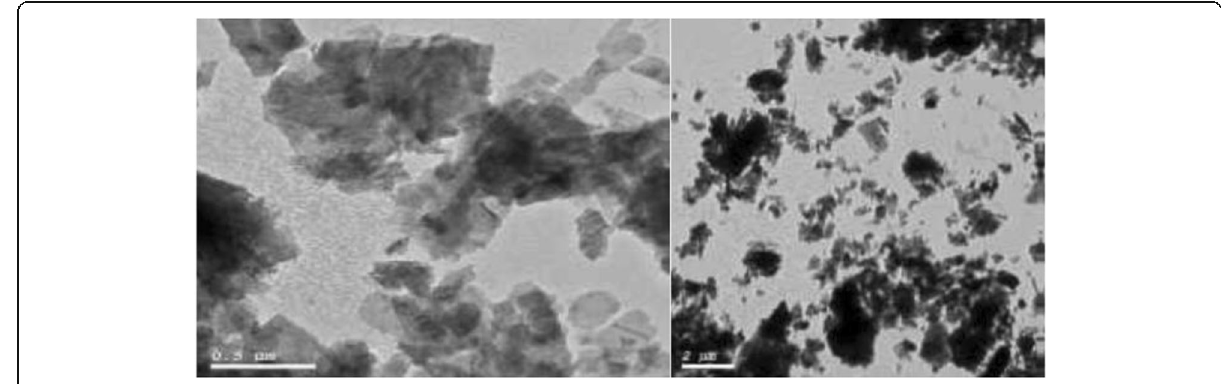
Fig. 1 TEM micrograph of nano